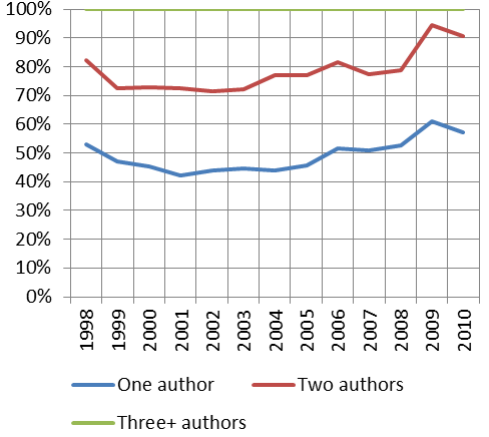
Figure 5: SKB articles according to number of authors across time 1997-2011 REGION : Volume 4, Number 3,